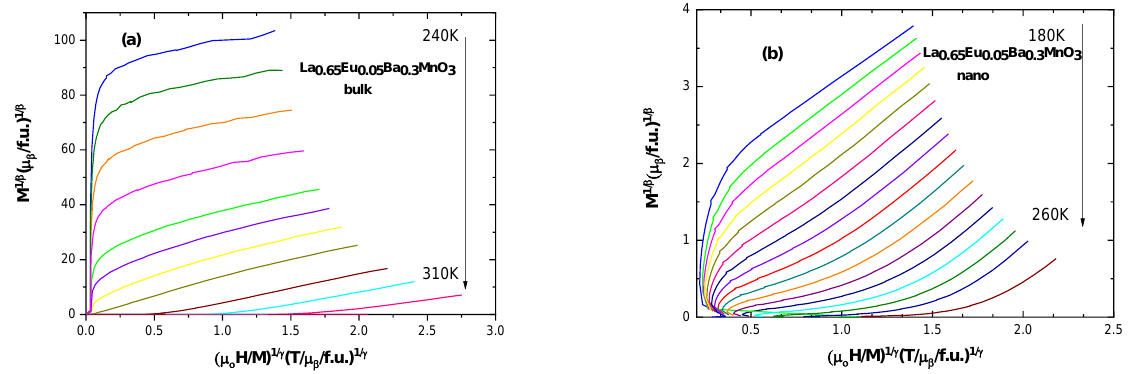
Figure 8. Modified Arrott plots for ( a ) the bulk sample with x = 0.05 and for ( b ) the nanocrystalline sample with x = 0.05.